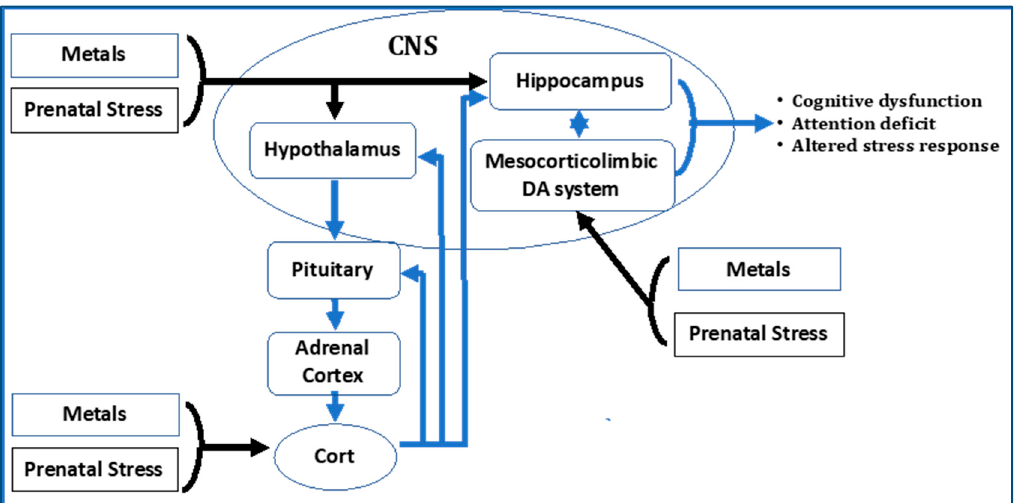
Figure 1. Both metals and prenatal stress act on brain regions including hippocampus, hypothalamus and mesocorticolimbic dopamine regions of brain. Both metals and prenatal stress also impact the HPA axis. This provides common biological substrates for interactions of metals and prenatal stress. HPA axis and brain mesocorticolombic systems have extensive interactions important to mediation of behaviors, including cognition and attention. Modified from Sobolewski et al., 2018 [60].